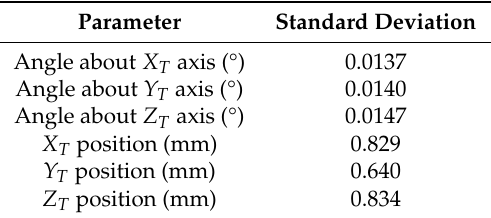
Table 4. Standard deviations of dynamic six-degree-of-freedom (6-DOF)